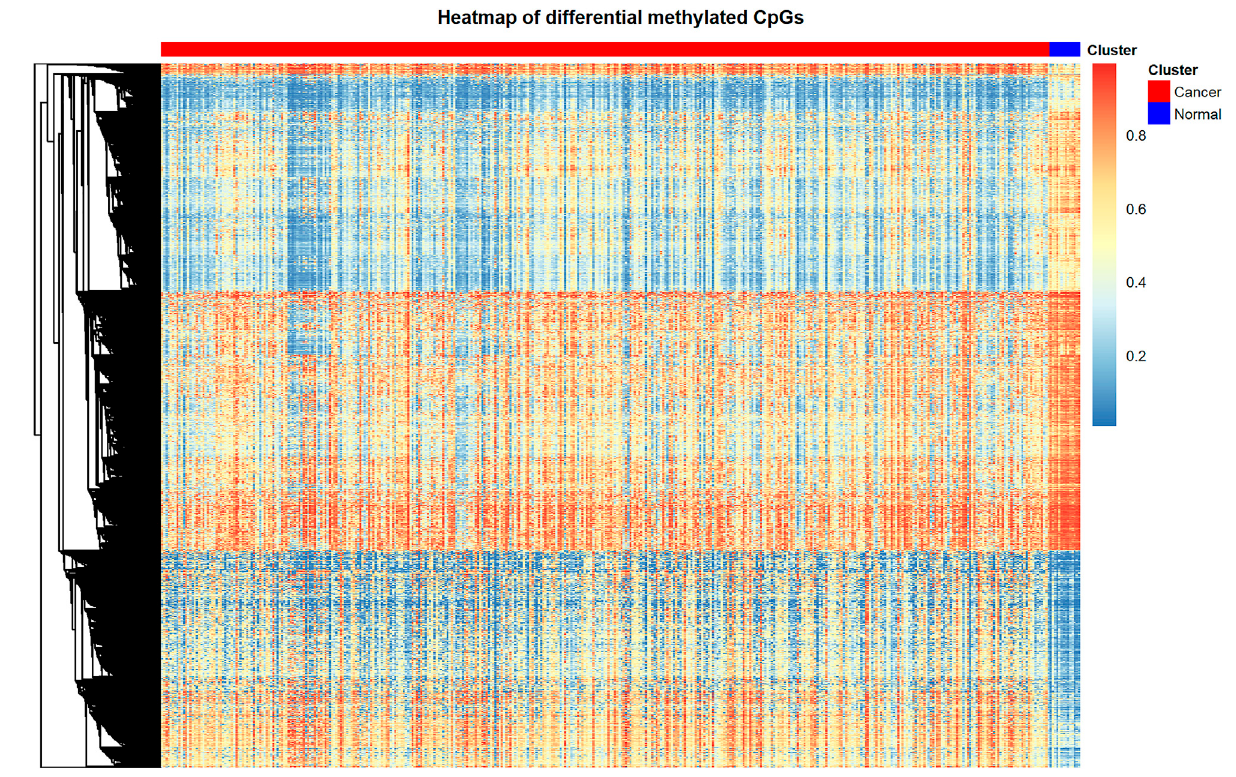
FIGURE 1 | Heat map of differentially methylated